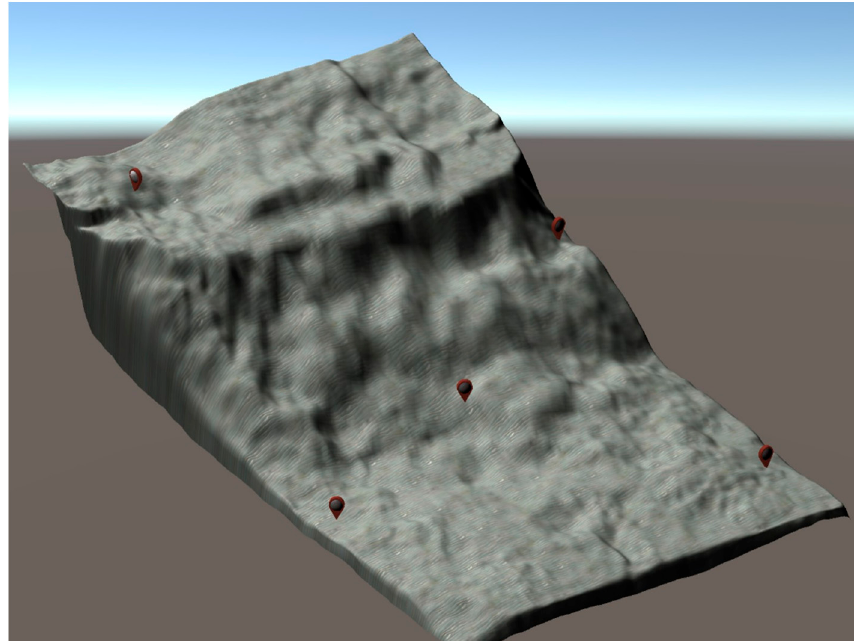
Figure 6. A sample of a landslide.